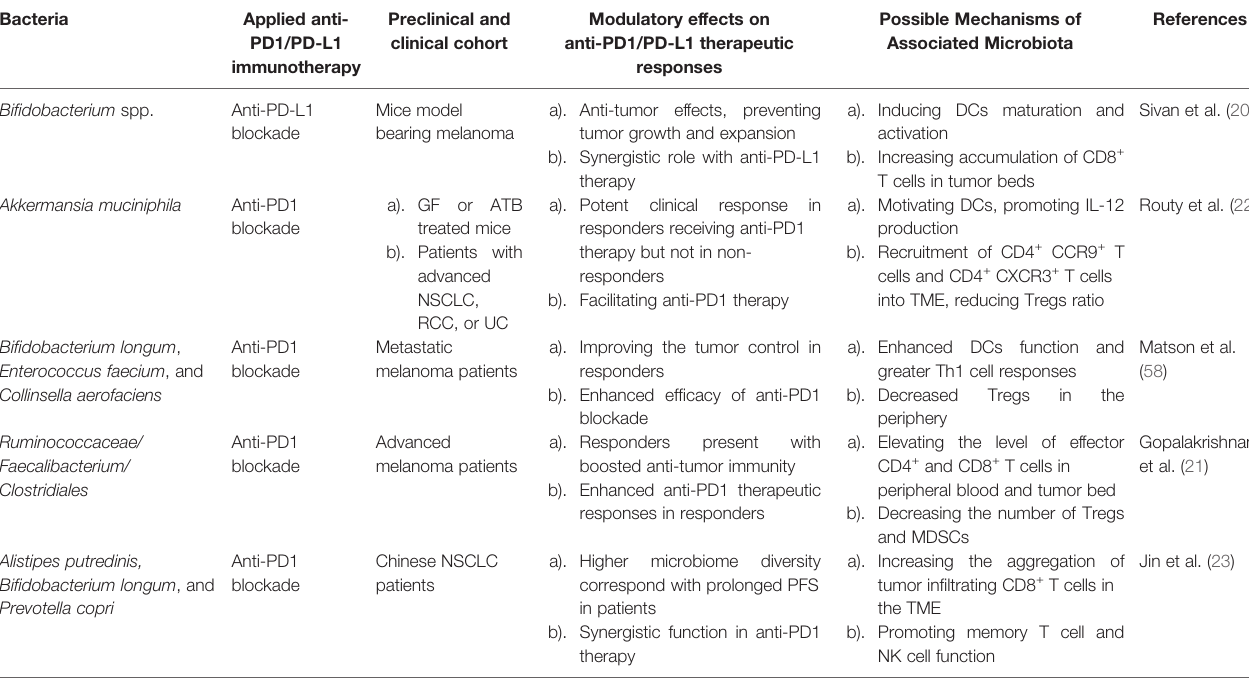
TABLE 1 | Regulatory role of gut microbiota in anti-PD1/PD-L1 therapy.